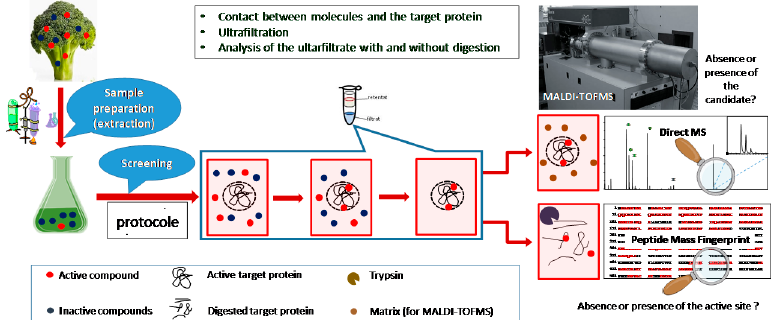
Figure 1. Principle of the direct screening protocol. The plant is first undergoing extraction with appropriate solvents. The, the extract is put in contact with the target protein to form a complex with the active candidates. The complex is ultra-filtrated to eliminate non active compounds before MALDI-TOFMS analysis. The retentate is directly submitted to MS analysis to check if one candidate (or even several) bound to the target protein and after a protein digestion to check the presence of the target active site by peptide mass fingerprint (PMF), it can be determined if the inhibition is reversible or not.